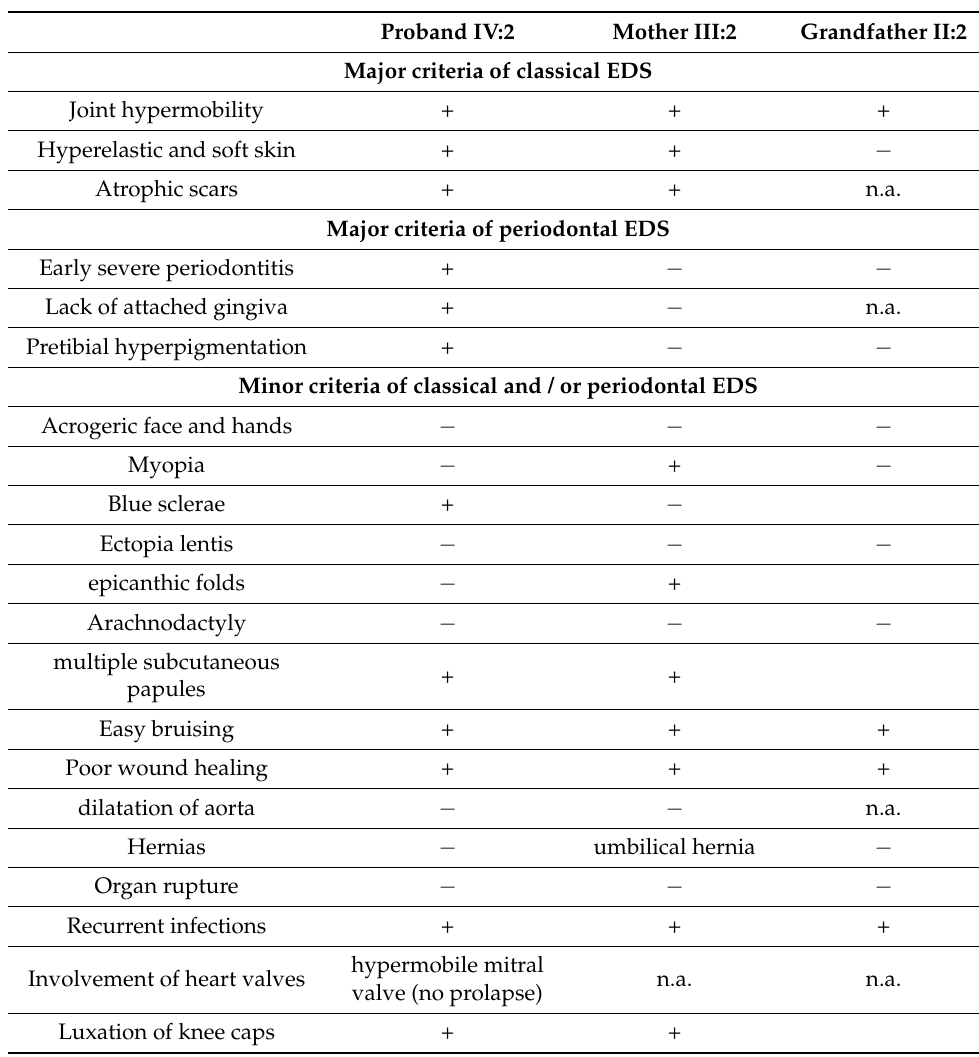
Table 1. Clinical Features of classical and periodontal Ehlers-Danlos syndrome (EDS) in the present family.